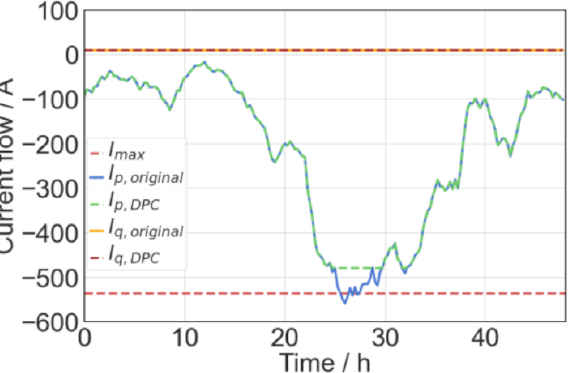
Figure 19. Current flow through line 6 before (blue trace) and after DPC application (green